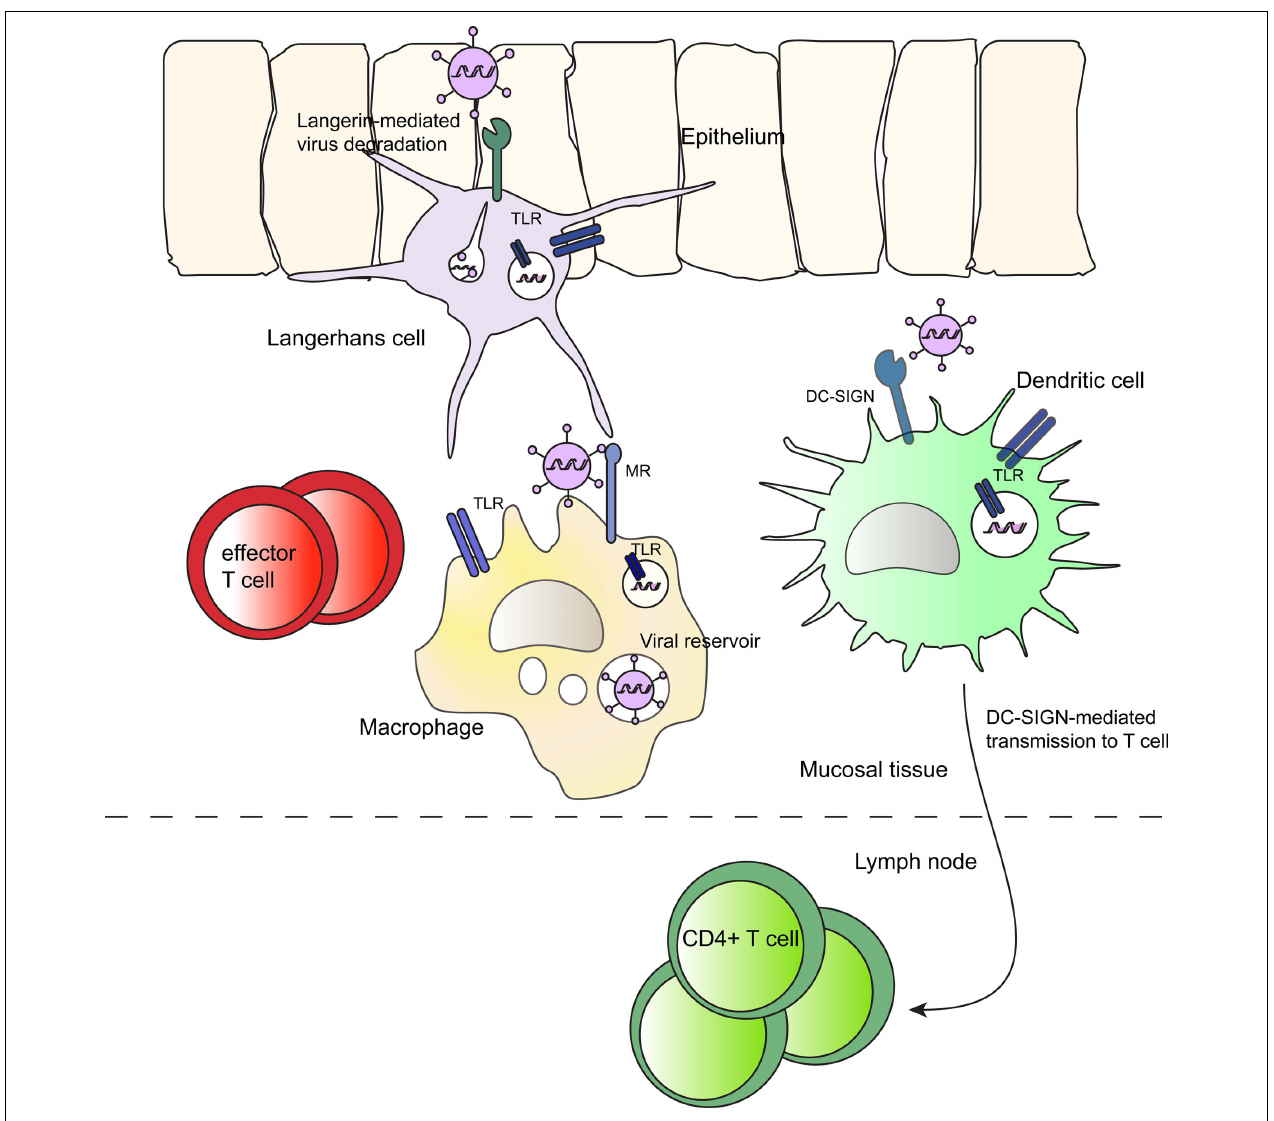
granules. Macrophages take up HIV-1 via MR, but are most important as an HIV-1 reservoir. All three innate immune cells in addition express various TLRs on the cell surface and in endosomes to sense pathogenic-derived antigens. SubsequentTLR signaling influences HIV-1 infection and immune